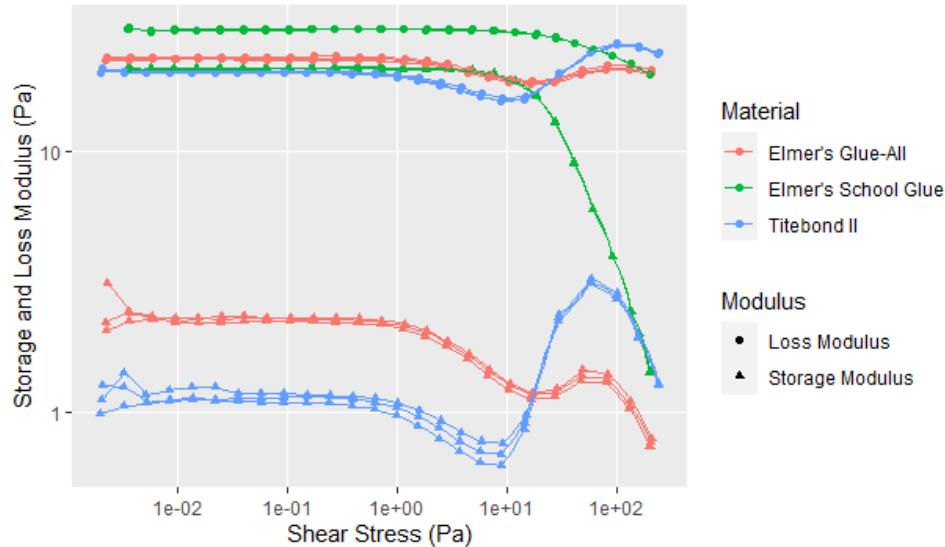
Figure 17. Shear rheology with increasing amplitude of commercial PVA-based adhesives: Elmer’s Glue-All and School Glue, and Titebond II.